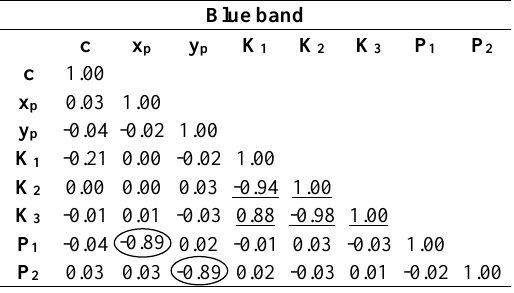
Table 4: Correlation matrix - Blue